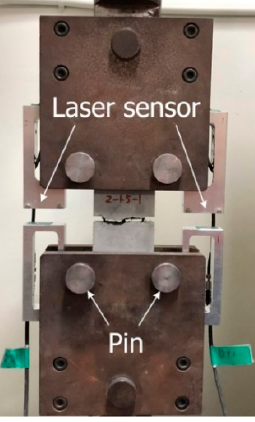
Figure 6. Set-up and instrumentation for direct tensile test.